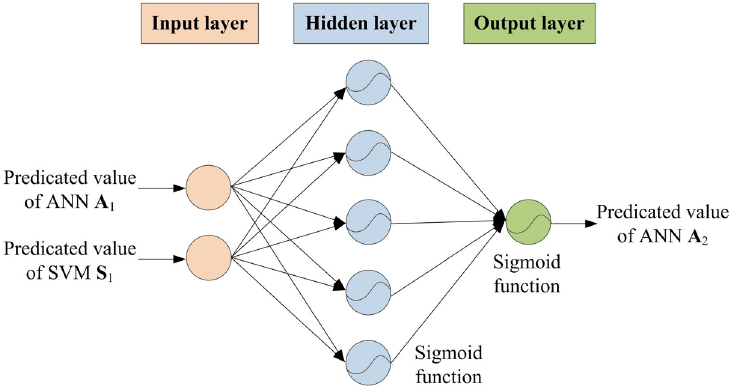
Figure 8. The optimal structure for ANN model A 2